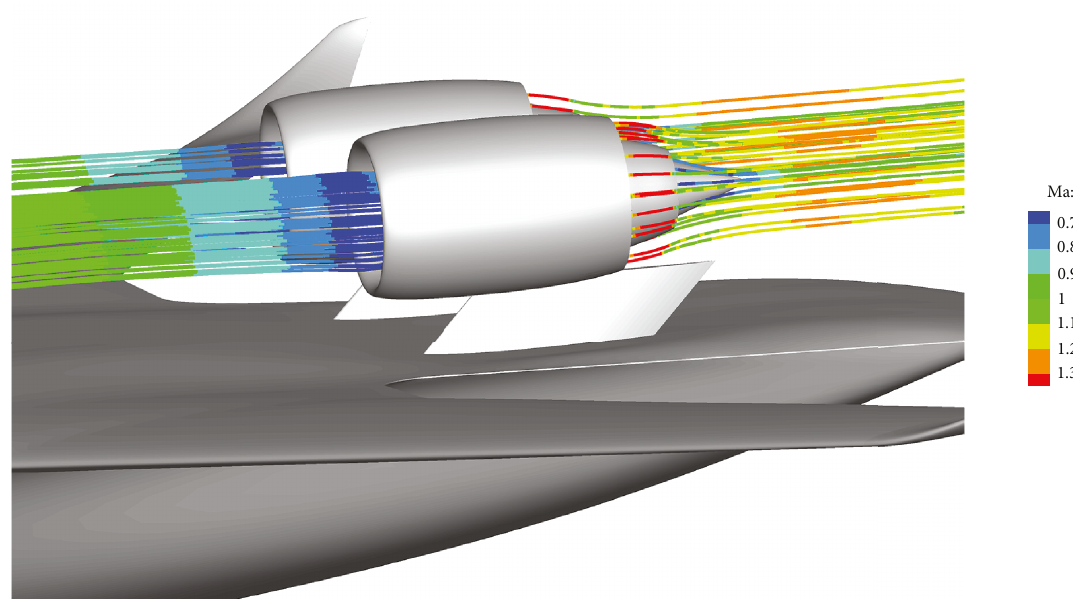
Figure 14: In fl ow and out fl ow streamlines of the engine at the cruise state.